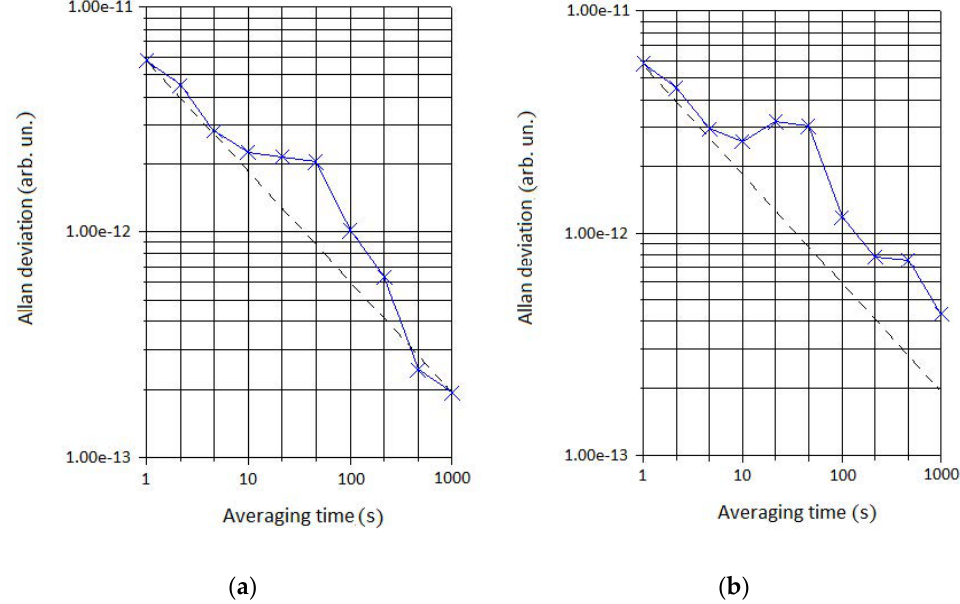
Figure 5. Orientation dependences of the 0-0 resonance frequency on the angle θ (the dots indicate the experimental values of the orientational shift). Allan deviation dependence of atomic clock No. 1 on the averaging time (dotted line—Allan deviation for atomic clock No. 1 without external magnetic field modulation): ( a ) with magnetic field modulation with an amplitude of 1.5 A/m along the Z (phase shift 0 ◦ ) and X (phase shift 90 ◦ ) axes; ( b ) with modulation of the magnetic field with an amplitude of 3 A/m along the Z (phase shift 0 ◦ ) and X (phase shift 90 ◦ ) axes.